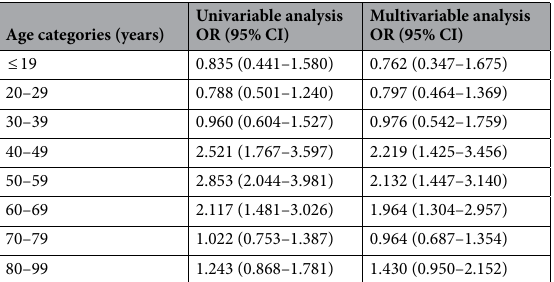
Table 3. Effect of female sex compared to male sex on extrapulmonary tuberculosis according to age category. The multivariable model was adjusted for age, sex, body mass index, current smoking status, heavy alcohol intake, and the presence of comorbidities. OR odds ratio, CI confidence interval.